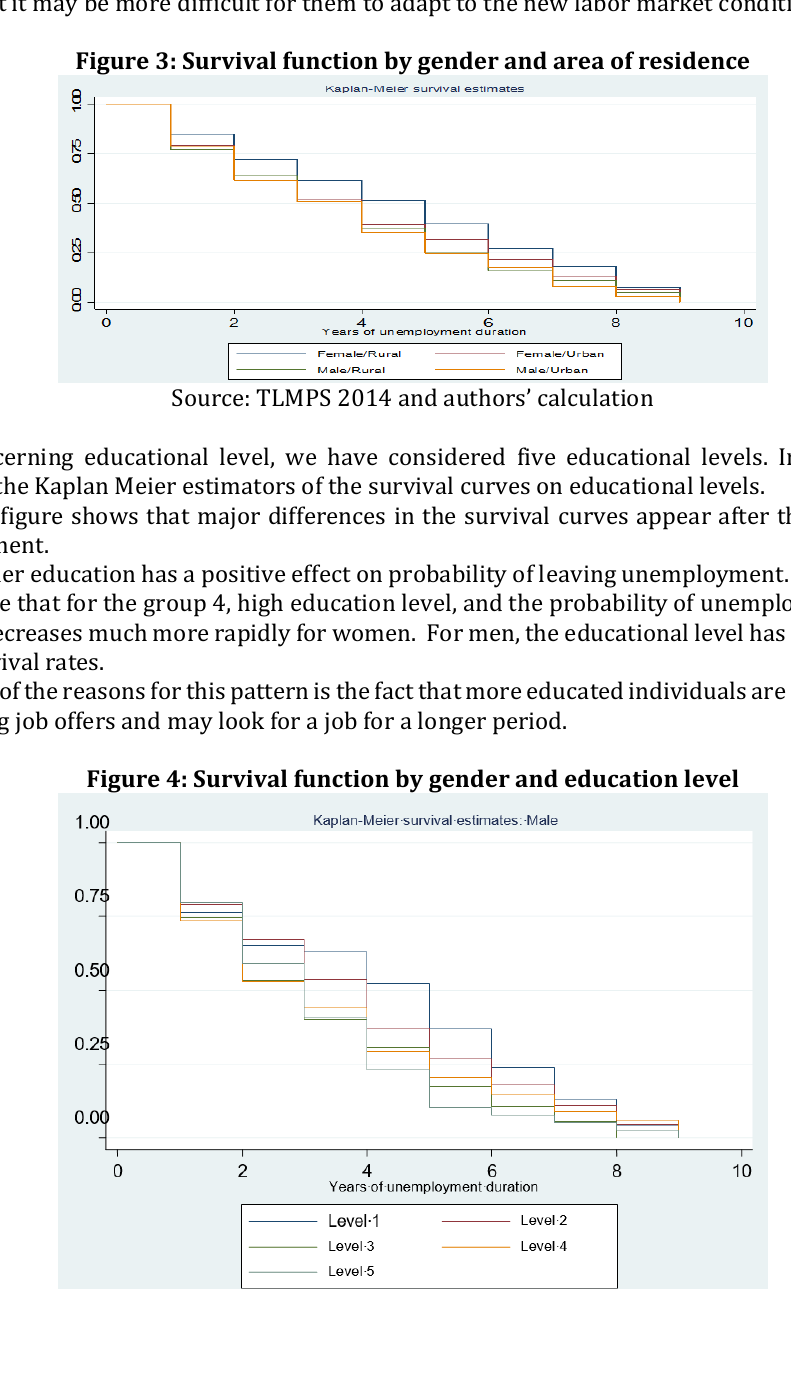
Figure 3: Survival function by gender and area of residence